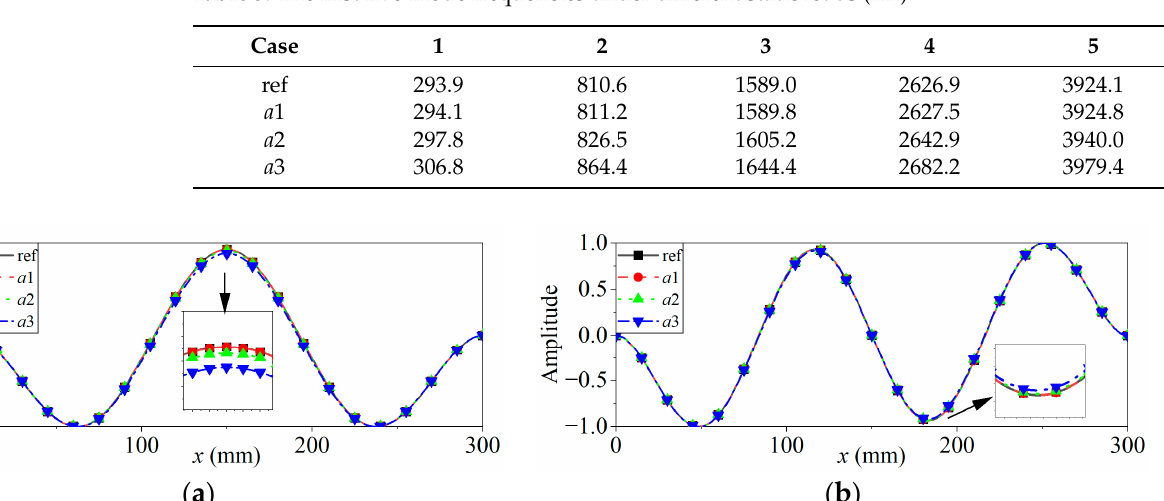
Table 5. The fi rst fi ve-mode frequencies under di ff erent static loads (Hz). Table 5. The first five-mode frequencies under different static loads (Hz).